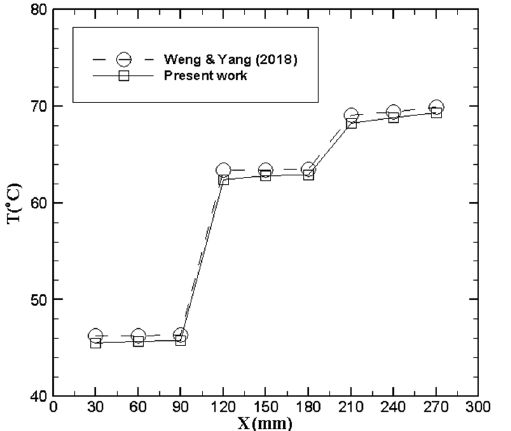
Figure 3. Comparison of the results of present study with those of available work.